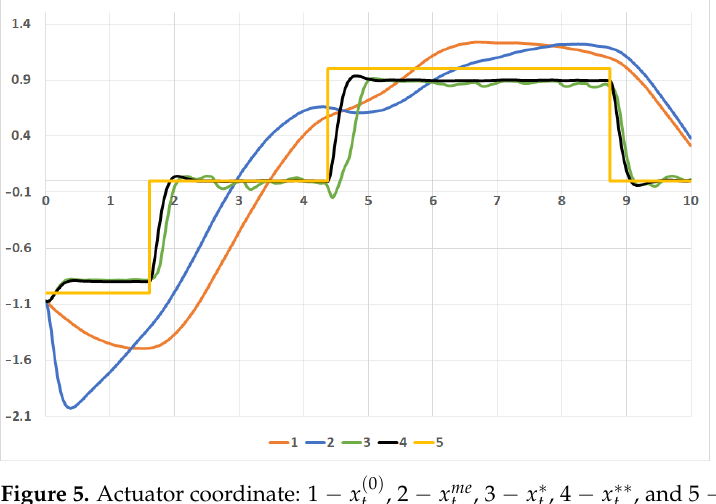
Figure 5. Actuator coordinate: 1 − x